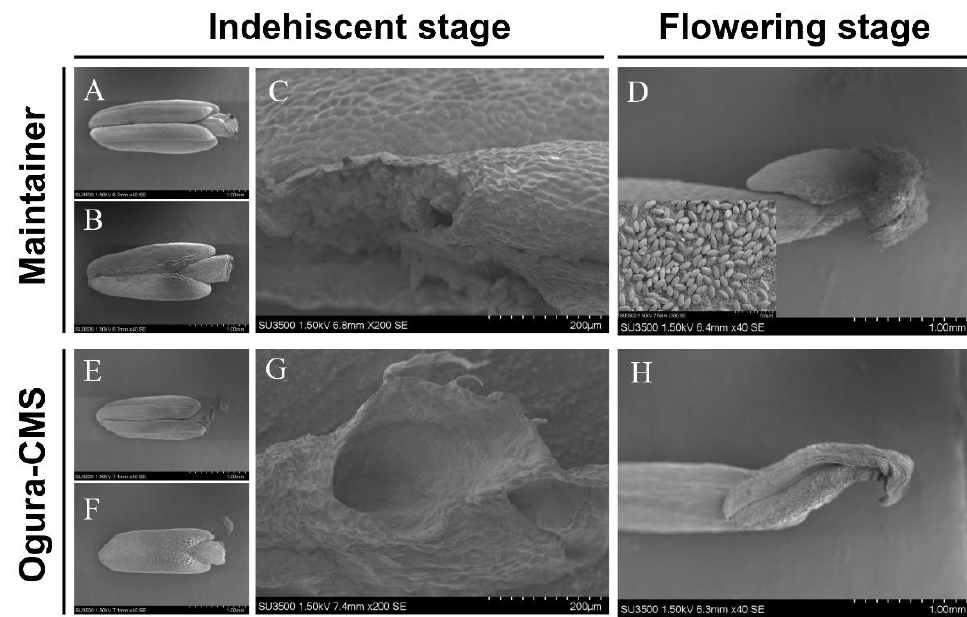
Figure 1. Scanning electron microscopy observation of anthers in the Ogura CMS line and the maintainer line of Chinese cabbage. ( A , B ) mature anthers at the indehiscent stage from the maintainer line (231–330); ( C ) local magnification of a mature anther incised at the indehiscent stage in the maintainer line; ( D ) mature anther at the flowering stage with normal oval, plump pollen grains in the maintainer line; ( E , F ) Mature anthers at the indehiscent stage from the Ogura CMS line (Tyms); ( G ) local magnification of a mature anther incised at the indehiscent stage in the sterile line, showing empty chambers; ( H ) a mature anther at the flowering stage had no pollen and was collapsed in the sterile line. Bar = 1 mm in ( A , B , E , F ), 200 μm in ( C , G ), and 1 mm in ( D , H ).